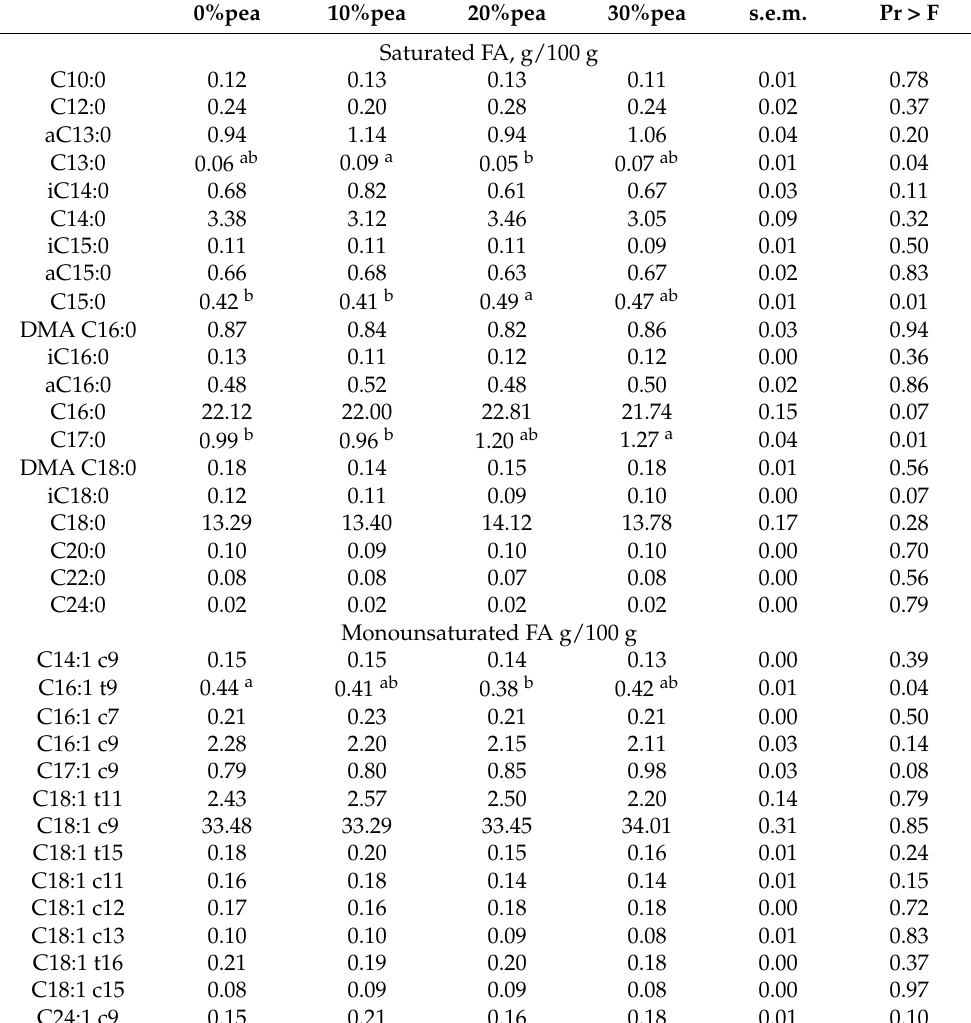
Table 4. Effect of the proportion of pea in the individual saturated and monounsaturated fatty acids (FA) in LTL